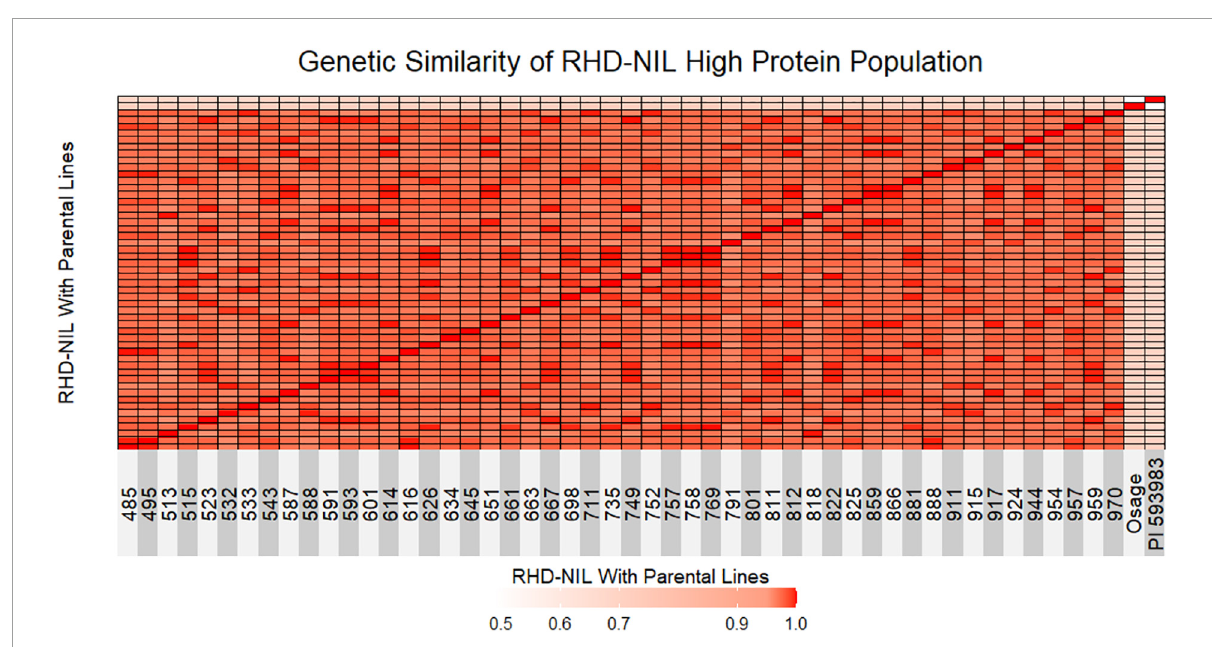
FIGURE2 Genetic similarity test between individual RHD-NIL and parental lines is shown as a heatmap. Red indicates 1.0 genetically similar, light red indicates 0.90 genetically similar, and light pink indicates less than 0.50 genetically similar. Osage represents parent one and PI 593983 represents parent